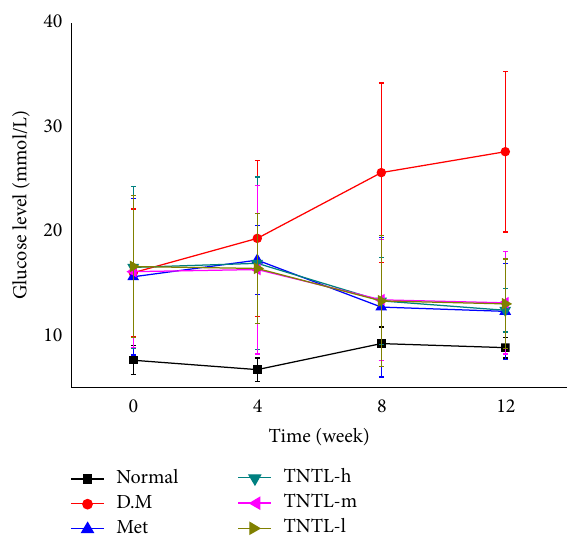
Figure 3: Fasting blood glucose levels of db/db mice. Fasting blood glucose levels of db/db mice with no treatment or with metformin and TNTL (TNTL-h, m, l = 3.6 g, 1.8 and 0.9 g/kg BW, resp.) oral administration. TNTL exhibits hypoglycemic effect with sustained medication. Normal: C57BL, DM: db/db mice with untreated, Met: db/db mice treated with metformin, and TNTL-h, m, l: db/db mice